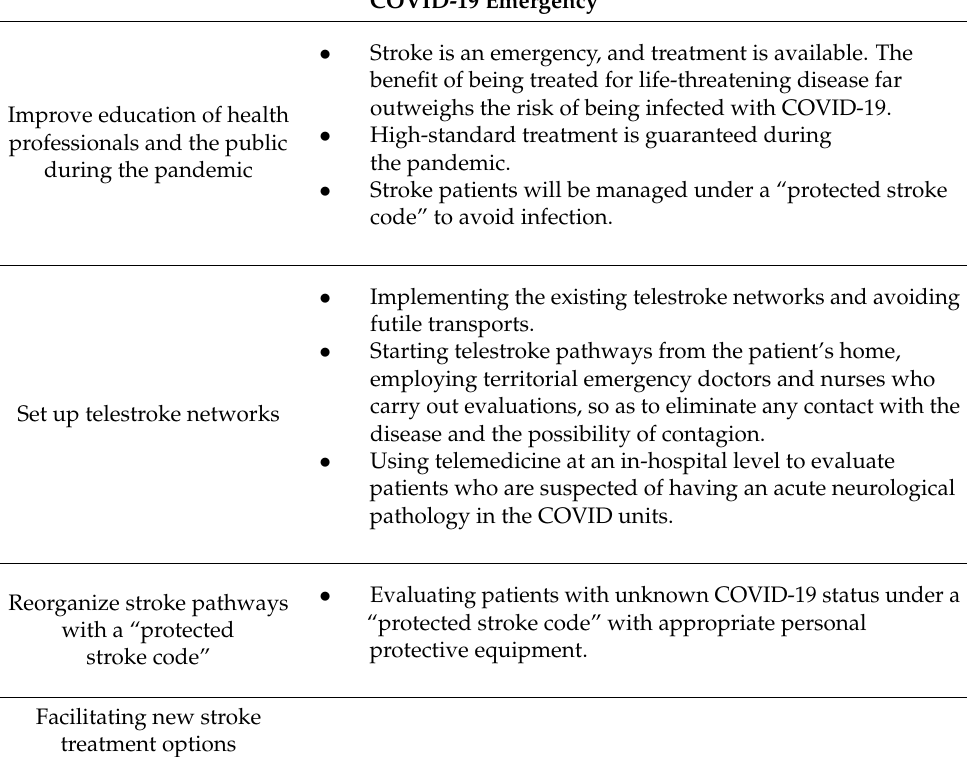
Table 4. New proposal for the COVID-19 emergency. New Proposals for the Management of the COU of the Neurology and Stroke Unit during